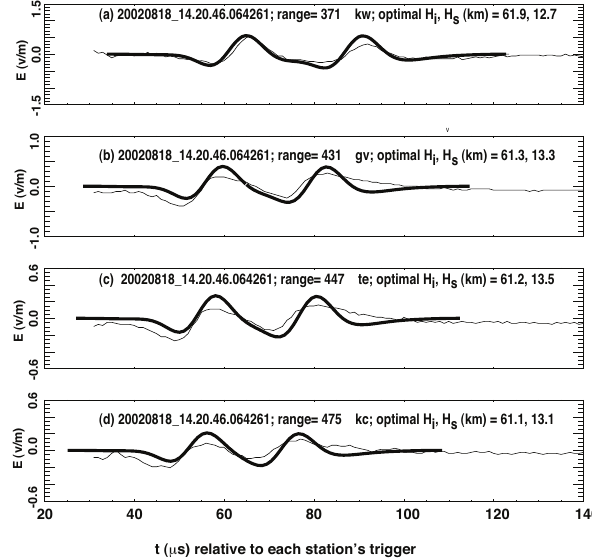
Fig. 1. Five-station LASA recordings at 14:20:46.624 UT from 18 August 2002, of the vertical electric field versus time during arrival of signals from a Narrow Bipolar Event. The zero of the time axis is set individually for each station, at that station’s own trigger time. The ground wave is near t =0. The bold portion of data in the second panel is the subset of data identified as “groundwave” and then both delayed and filtered to estimate the ionospherically-reflected signal. The small electric-field features near the dashed lines are the echoes from the ionosphere and from the ground-ionosphere combination. The dashed lines indicate modeled arrival times using a single iono- spheric height ( H i =61.2km) and source height ( H s =13.1km). See text.